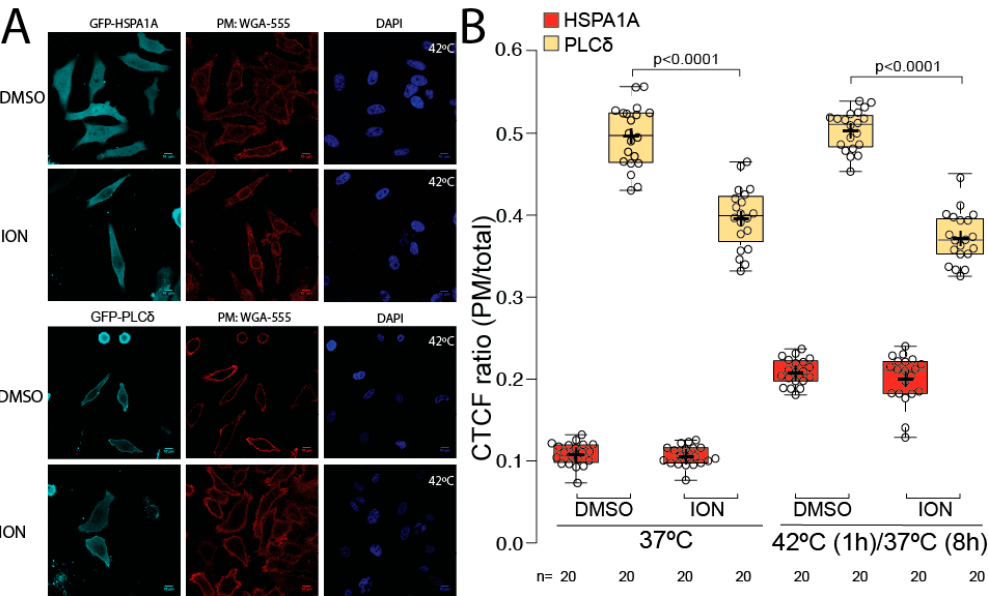
Figure 4. Plasma membrane localization of HSPA1A is not affected by ionomycin. ( A ) Representative images of HeLa cells expressing GFP-HSPA1A (two top panels) and GFP-PLC δ (two bottom panel). Cells were either incubated with DMSO (untreated controls; first row of each panel) or treated with 10 μ M ionomycin for 2 min (second row of each panel). Only heat-shocked cells are shown. The PM of all cells was stained with WGA-FA555 and the nucleus with DAPI (second and third picture of each panel, respectively). Scale bar = 10 μ M. ( B ) Quantification of the corrected total cell fluorescence (CTCF) as a ratio between the total fluorescence at the PM and the rest of the cell at control conditions and after heat shock in the presence or absence of ionomycin. The experiment was repeated three times, and the total number of cells (shown as open circles) per condition are shown at the bottom of the graph. The center lines show the medians; box limits indicate the 25th and 75th percentiles as determined by R software; whiskers extend 1.5 times the interquartile range from the 25th and 75th percentiles; crosses represent sample means.